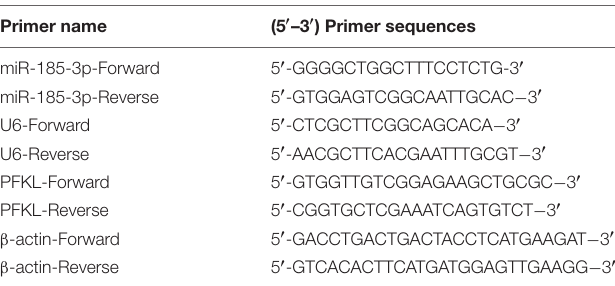
TABLE 1 | Primer sequences for